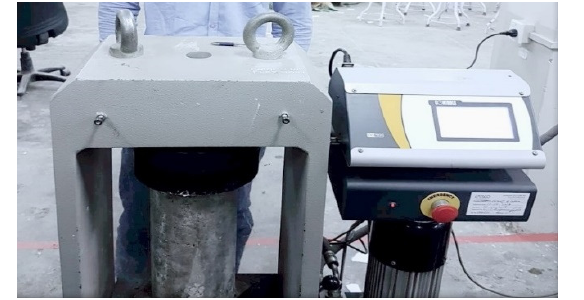
Fig. 5: Casting of Cylinders